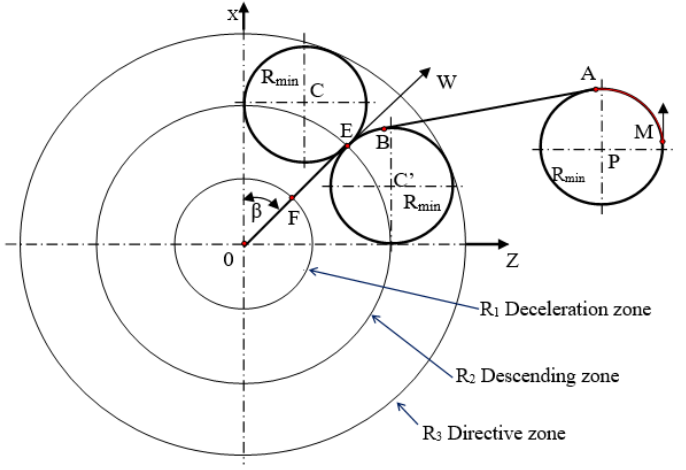
Figure 17. The proposed UAV landing zones.